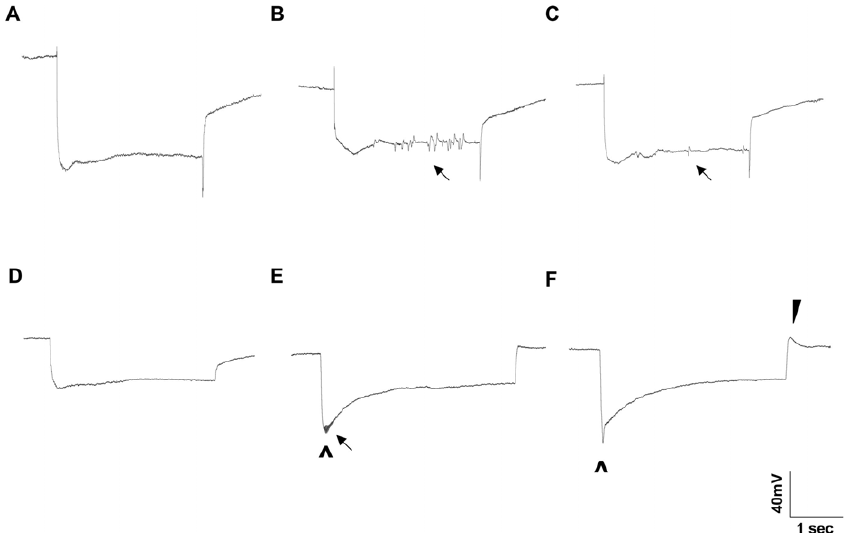
Figure 4. Carcinine Treatment Induces an ine 2 -Like ERG Phenotype in Wild-Type and ebony 11 Flies ERG recordings from untreated (A) wild-type and (D) ebony 11 flies and 5% carcinine-treated (B, C) wild-type and (D, E) ebony 11 flies. Note that while untreated wild-type and ebony 11 ERG recordings lack oscillations and a hyperpolarization response in response to light, ERG recordings from wild-type flies treated with 5% carcinine overnight display weak oscillations (arrows) in ; 35% of tested animals and ERG recordings from ebony 11 flies treated with 5% carcinine exhibit depolarization spikes in response to light (unfilled arrowhead), as well as weak oscillations (arrow) and a hyper-repolarization upon the termination of light (arrowhead).